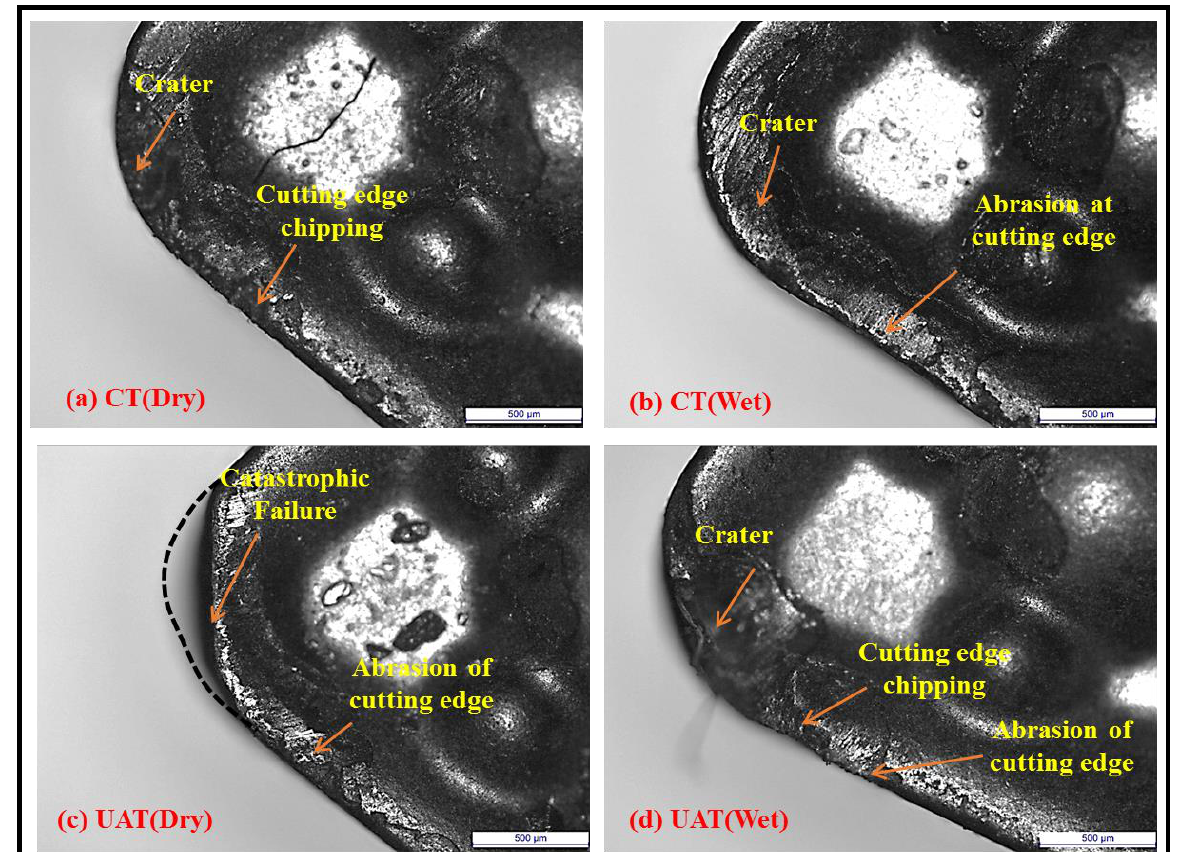
Figure 7. Characteristics of crater wear observed by optical microscope ( 𝑉 = 50 m/min, 𝑓 = 0.2 mm/rev, 𝑎 = 0.4 mm).